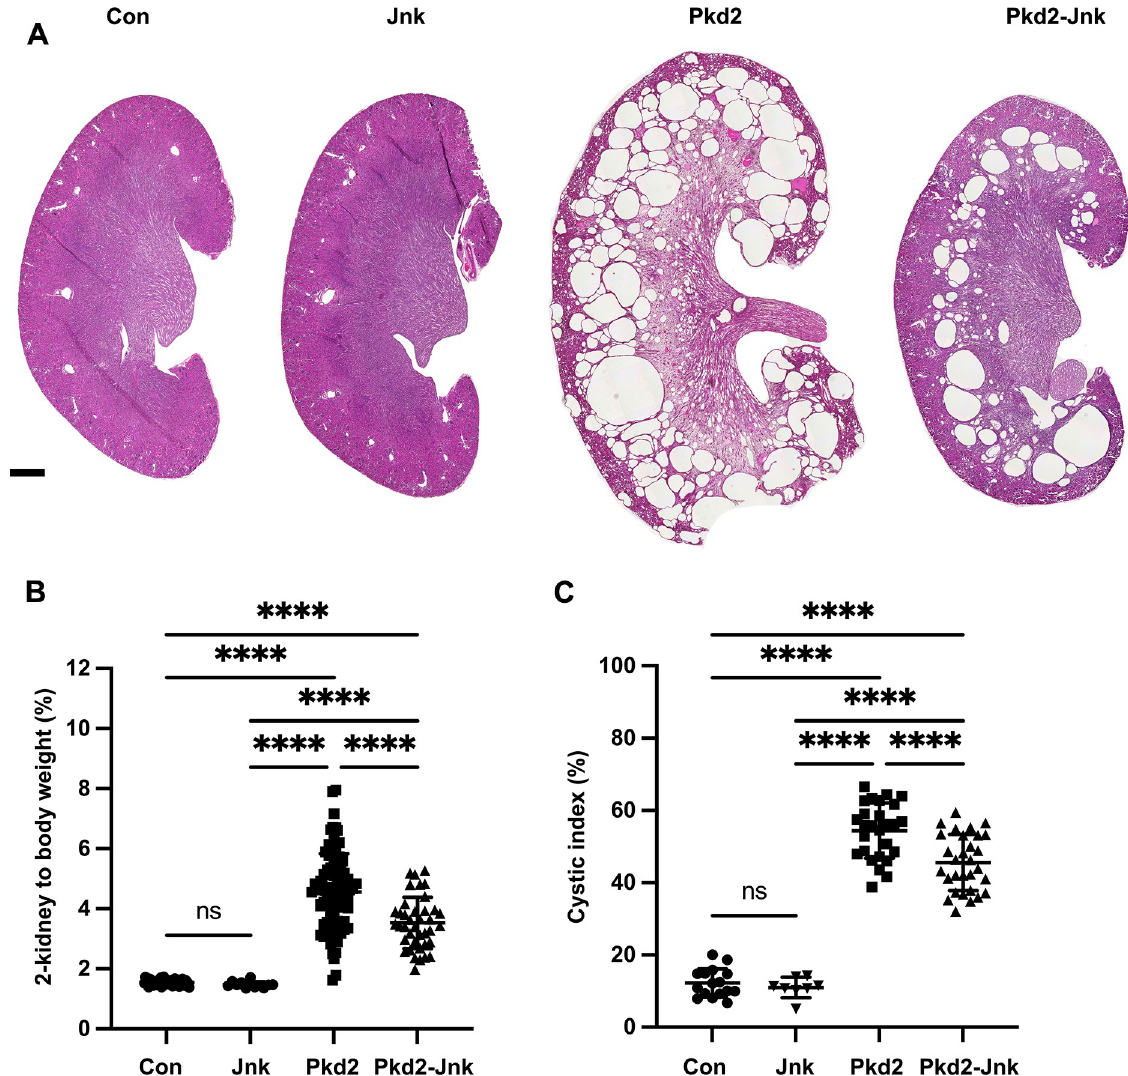
Fig 2. JNK inhibition reduces kidney cysts in juvenile Pkd2 mutant mice. Mice with the following genotypes were treated with tamoxifen by maternal transfer at P2-4 and collected at P21: Con (Rosa26-CreERT2; Pkd2fl/+), Jnk (Rosa26-CreERT2; Pkd2fl/+; Jnk1fl/fl; Jnk2null/ null), Pkd2 (Rosa26-CreERT2; Pkd2fl/fl; Jnk1+/+, fl/+; Jnk2+/+, +/-), and Pkd2-Jnk (Rosa26-CreERT2; Pkd2fl/fl; Jnk1fl/fl; Jnk2null/null). (A) Kidney sections from P21 mice were stained with H&E to show the extent of disrupted organ architecture. Scale bar is 500 microns and applies to all images in the panel. (B) Cystic burden was quantified using the ratio of 2-kidney weight / body weight x 100%. N is 42 (Con), 12 (Jnk), 88 (Pkd2), 39 (Pkd2-Jnk). ���� , P < 0.0001 by one-way ANOVA followed by Tukey multiple comparison test with multiplicity-adjusted p-values. Error bars indicate SD. (C) Cystic index (cystic area / total kidney area x 100%) was calculated for mid-sagittal H&E-stained kidney sections. N is 16 (Con), 8 (Jnk), 27 (Pkd2), 30 (Pkd2-Jnk). ���� , P < 0.0001 by one-way ANOVA followed by Tukey multiple comparison test with multiplicity-adjusted p-values. Error bars indicate